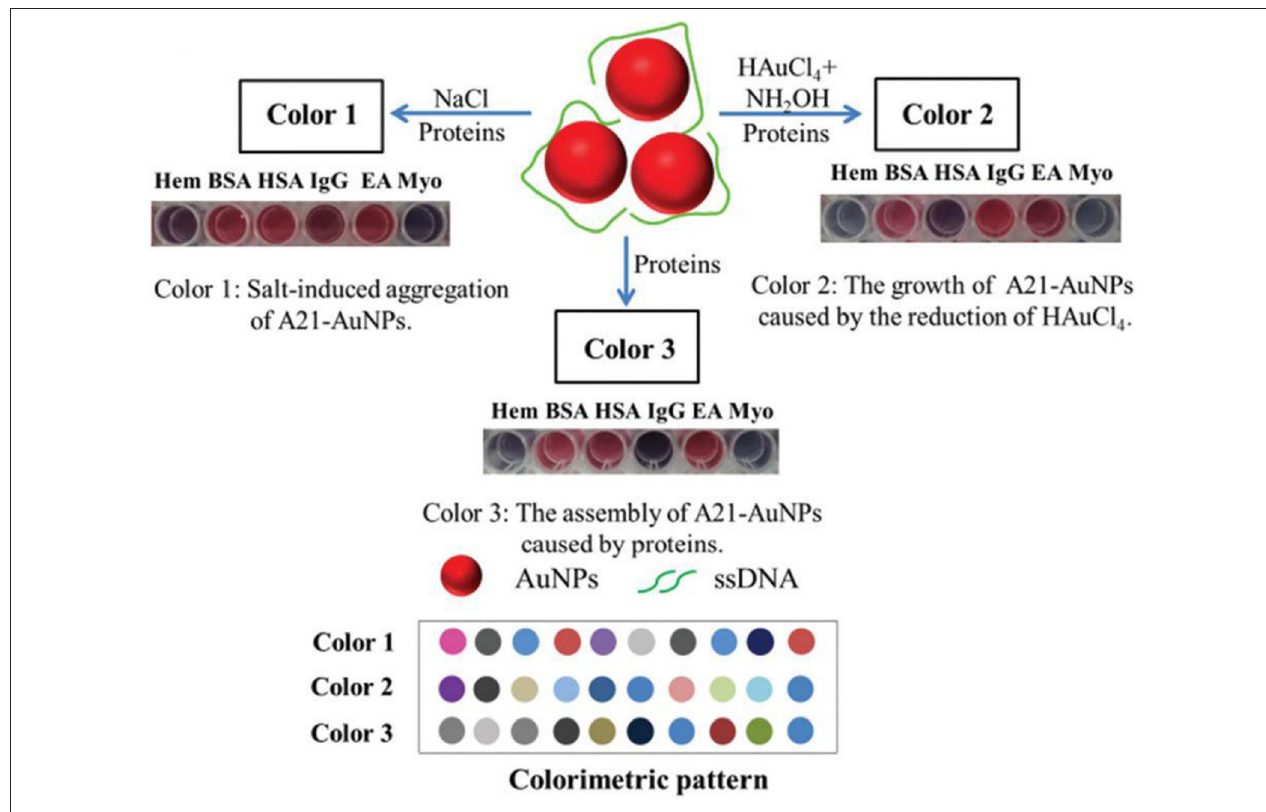
FIGURE 10 | Schematic representation of the triple-channel A21-AuNPs for protein sensing and the produced colorimetric pattern. Reprinted from Mao et al. (2016) with permission.